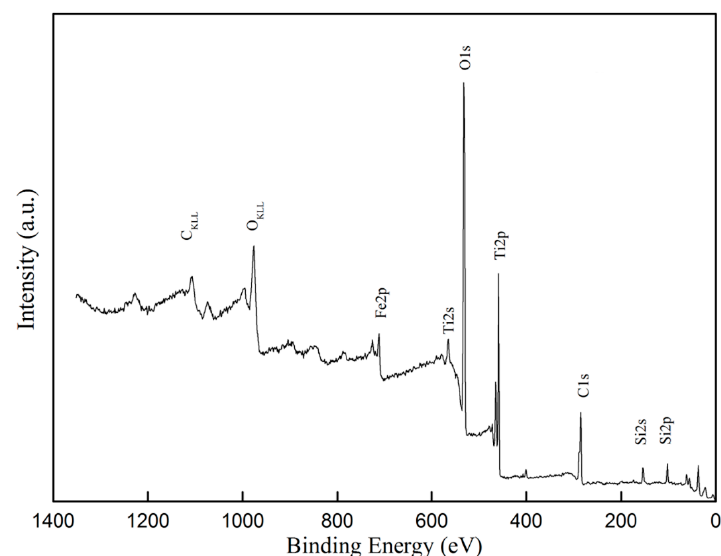
Figure 8. Full XPS spectrum of STCF-1.